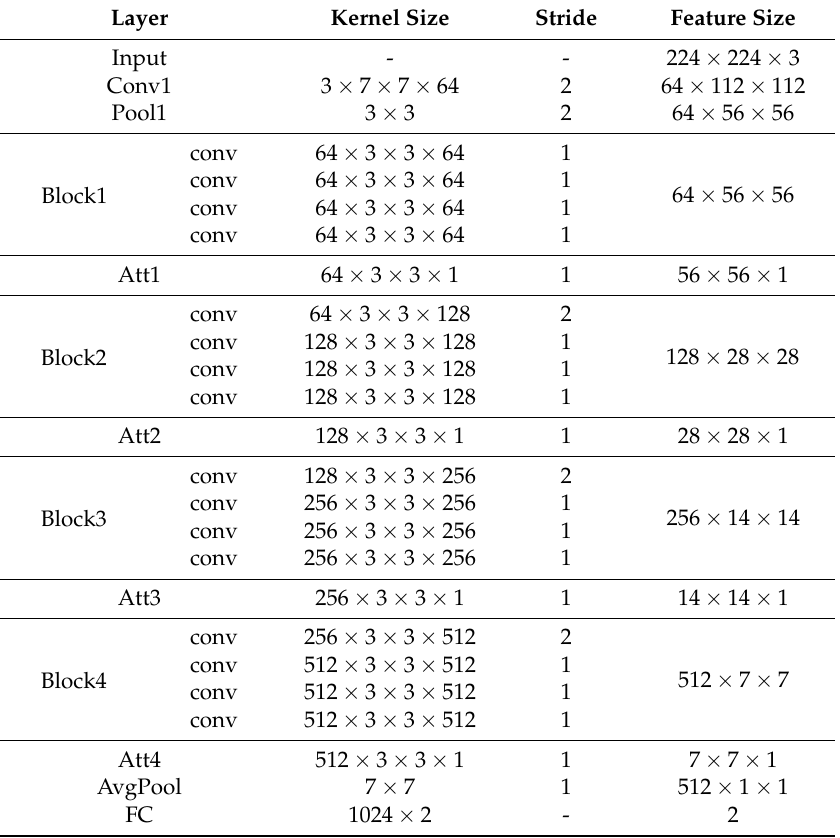
Table 1. The parameters, kernel size, kernel stride and the feature dimensions of proposed model.